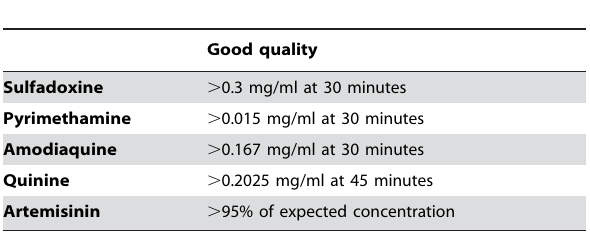
Figure 2. HPLC chromatogram showing the separation of mixture of standards of amodiaquine (AQ), quinine (QU), sulphadoxine (SUL) and pyrimethamine (PYR) all at 10 m g/ml; dihydroartemisinin (DHA), artesunate (AS) and artemether (AM) at 2 mg/ml. doi:10.1371/journal.pone.0003403.g002 Table 3. Classification for content analysis by HPLC for antimalarial